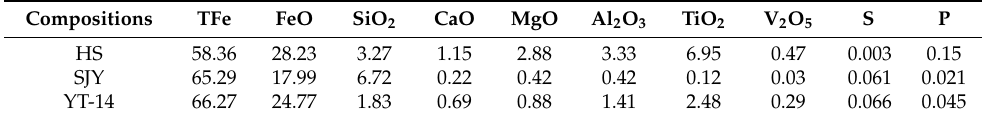
Table 1. Chemical composition of the experimental raw materials (mass/%).